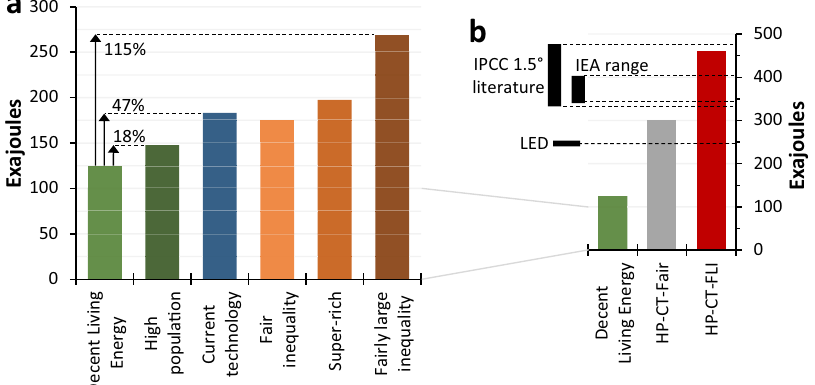
Fig.1|Estimatesofglobal fi nalenergyusecomparedtokeyscenariosfromthe literature. Total fi nal energy use in 2050 for the six scenarios ( a ). In panel b , the axis is expanded and three scenarios shown, including DLE and two combination scenarios: high population , current technology & fair inequality (HP-CT-Fair) and high population , current technology , & fairly large inequality (HP-CT-FLI). Various